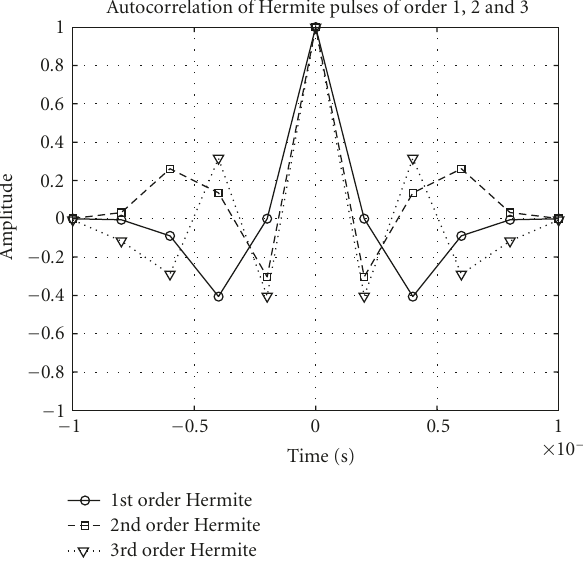
Figure 3: Autocorrelation values of short duration MHPs of 1st-, 2nd-, and 3rd-order